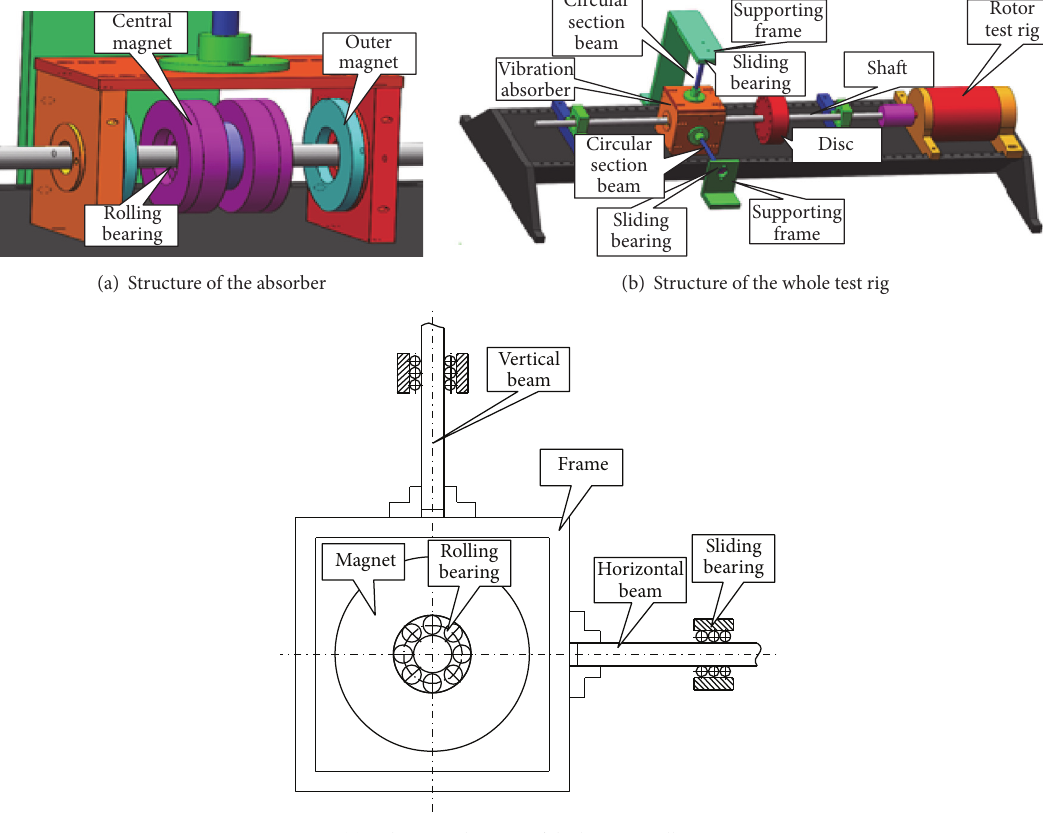
Figure 5: Structure of the dynamic vibration absorber and the rotor-absorber system.